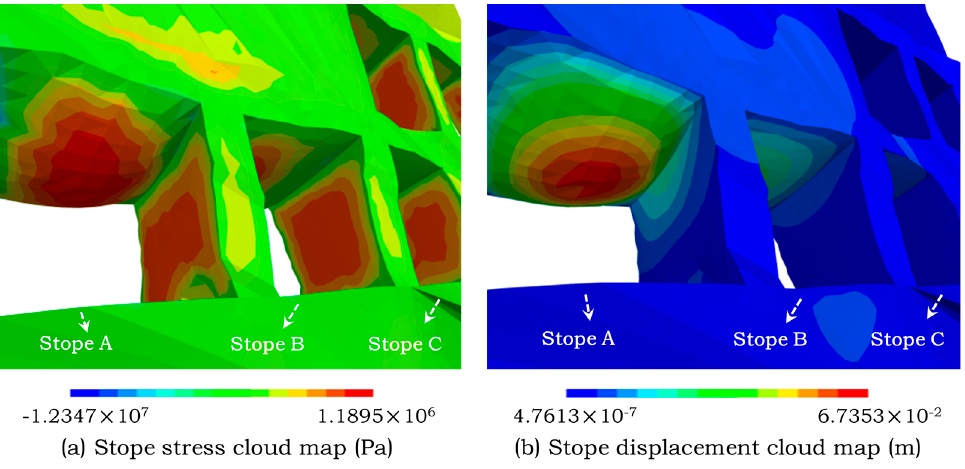
Figure 3. The stress and displacement color map of three targeted stopes (A/B/C). Table 2. The maximum displacement of each wall after the target stope is excavated. Stope